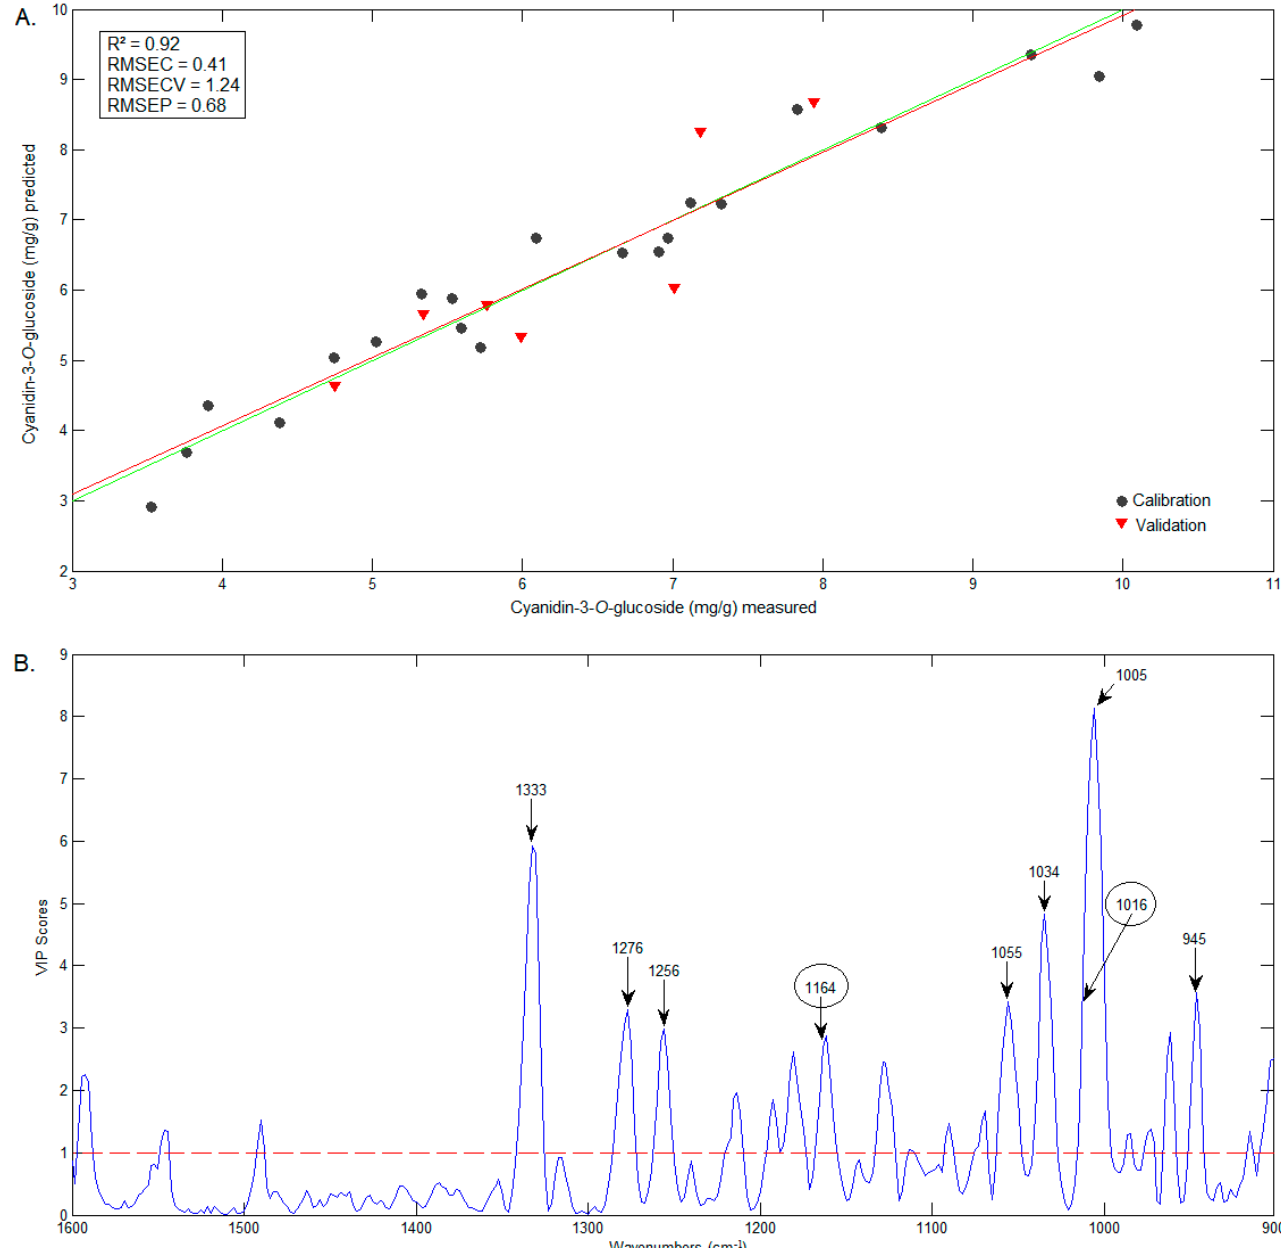
Figure 8. Graphics of the predicted vs. measured values ( A ) and of the VIP scores ( B ) of C3G. The comparison between predicted (FTIR) and measured (HPLC) contents of D3G and ellagic acid are presented in Figures 9A and 10A, respectively. The wavenumbers that most in fl uenced the D3G model (Figure 9B) are very similar to those of the C3G model (including 1346 cm − 1 ), and include the band at 1043 cm − 1 , identi fi ed in the D3G spectrum by Choong, Mohd Yousof, Jamal and Isa Wasiman [41]. In the case of ellagic acid, the wavenumbers that mostly in fl uenced the model (Figure 10B) include 1710 cm − 1 , previ- ously identi fi ed in the ellagic acid spectrum by Tavares, Pena, Martin-Pastor and Sousa [42]. However, the wavenumbers that mostly in fl uenced the model are in the range of 600– 669 cm − 1 , a region in which the bands have no reported association with the functional groups in ellagic acid.